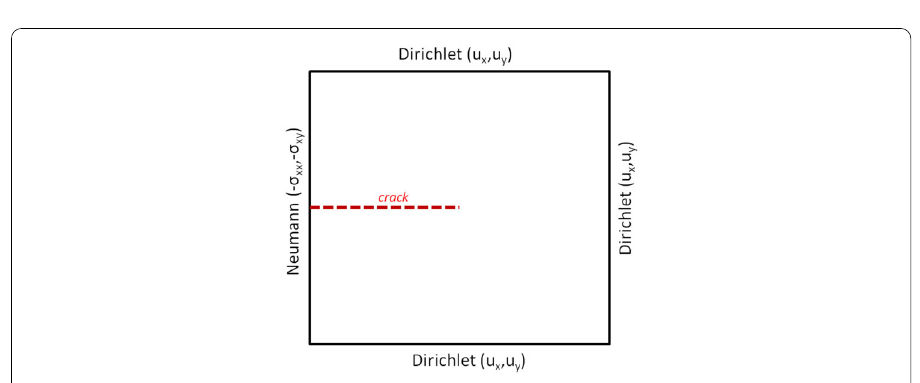
Fig. 19 Asymptotic behavior with Bernstein polynomials with dedicated pre-conditioners (same pre-conditioners as with linear elements). As with Lagrange polynomials, dedicated pre-conditioners do not solve accuracy